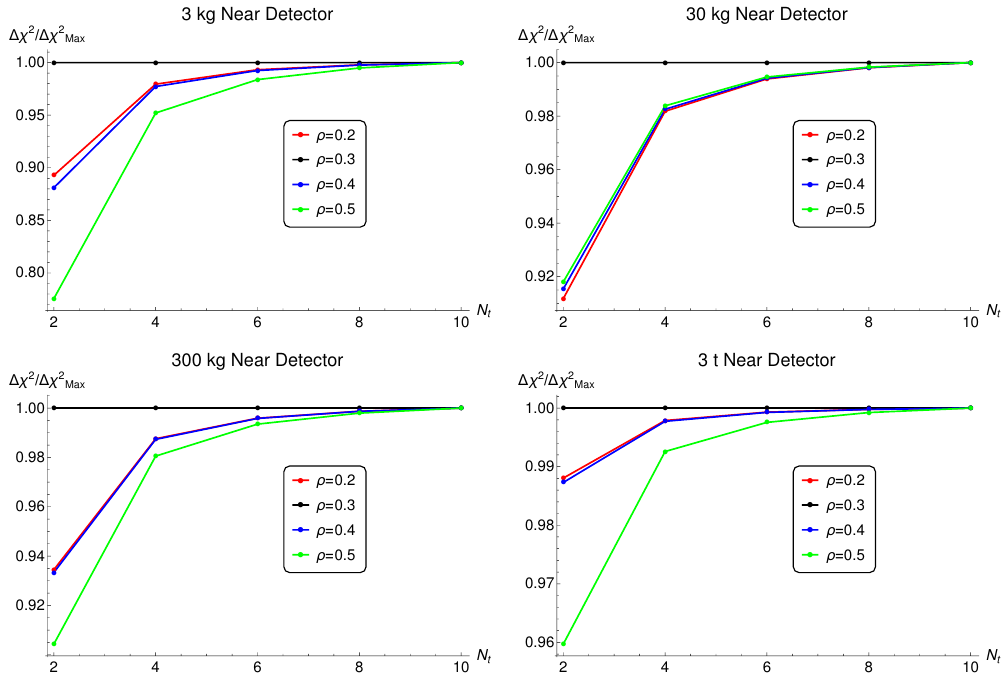
Figure 5 . (cid:1) (cid:31) 2 as a function of the number of time bins for di(cid:11)erent masses of the near detector. (cid:1) (cid:31) 2 is de(cid:12)ned as the (cid:1) (cid:31) 2 with N t = Max